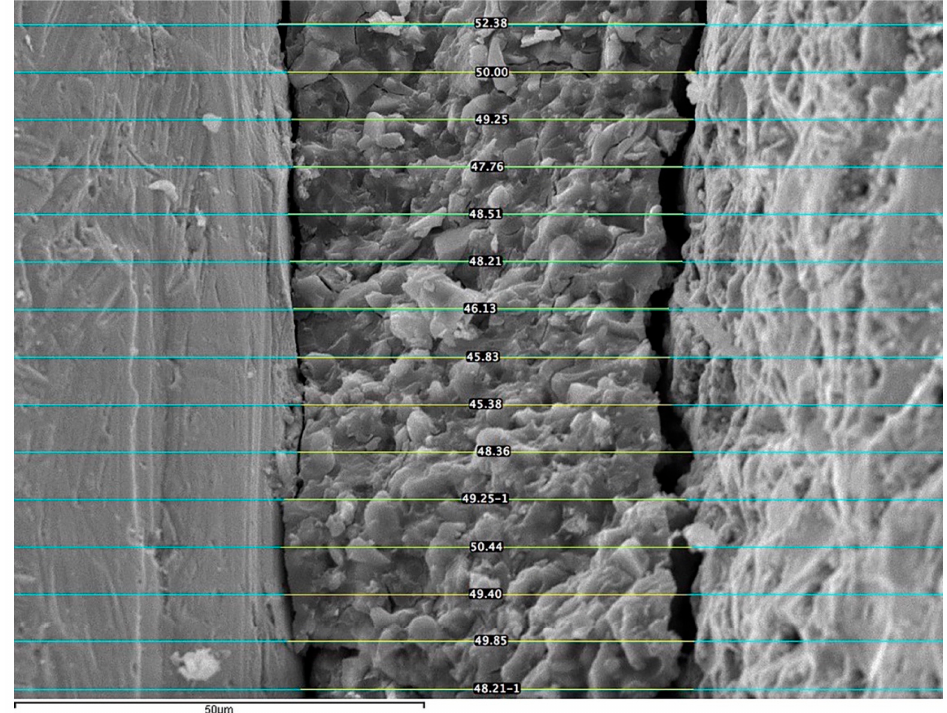
Figure 4. SEM image (1000×) calibrated with INCA software showing a marginal discrepancy of a CMc framework.